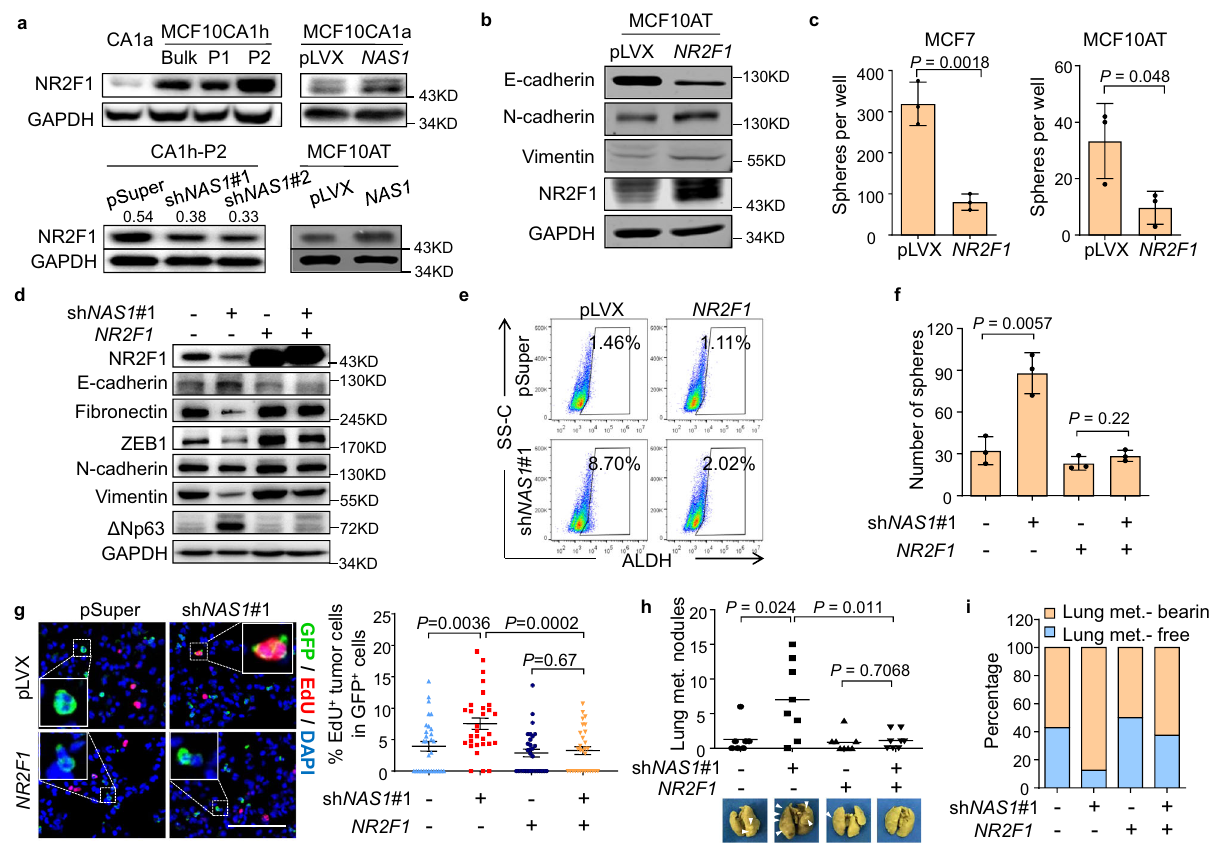
Fig. 4 NAS1 suppresses breast cancer lung metastasis by NR2F1. a NR2F1 expression in MCF10CA1a, MCF10CA1h, P1, and P2, or after NAS1 knockdown or overexpression. Relative quantitation of NR2F1 expression after NAS1 knockdown was shown for CA1h-P2 cells. b Expression of EMT markers after NR2F1 overexpression in MCF10AT. c Tumorsphere formation of MCF7 and MCF10AT after NR2F1 overexpression ( n = 3 culturing experiments). d – i Analyses of CA1h-P2 cells with NAS1 knockdown and/or NR2F1 overexpression. Shown are protein levels of EMT markers ( d ), fl ow cytometric analyses of the ALDH + BCSCs ( e ), tumorsphere formation ( f , n = 3 culturing experiments), representative IF images (left), and quantitation of EdU + tumor cells (right) in lungs 4 days after intravenous injection of the cells ( g , n = 30 RMFs from 3 mice), lung surface nodules 18 weeks after intravenous injection ( h , n = 7, 8, 8 and 8 mice, respectively), and the lung metastasis incidence ( i ). The triangles indicate metastatic nodules on the lung surface ( h ). Scale bar, 100 μ m. Data represent mean ± SD ( c , f ), mean ± SEM ( g ) or mean with single points ( h ). Arrows point to tumor nodules in ( h ). Statistical signi fi cance was determined by a two-tailed unpaired t test. Experiments in a , b , d , e were repeated at least three times independently with similar results; data from one representative experiment are